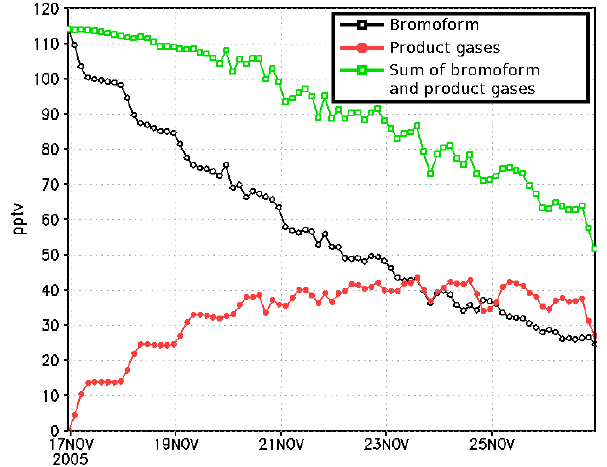
Fig. 3. Same as Fig. 2 but for HBr (green), for organic products Figure 3: Same as Fig. 2 but for HBr (green), for organic products (CBr 3 OOH (CBr 3 OOH+CHBr 2 OOH+CBr 2 O+CHBrO) (red) and for other +CHBr 2 OOH+CBr 2 O+CHBrO) (red) and for other inorganic products inorganic products (Br+BrO+HOBr+BrONO 2 ) (black) from the BG1 (Br+BrO+HOBr+BrONO 2 ) (black) from the BG1 simulation.